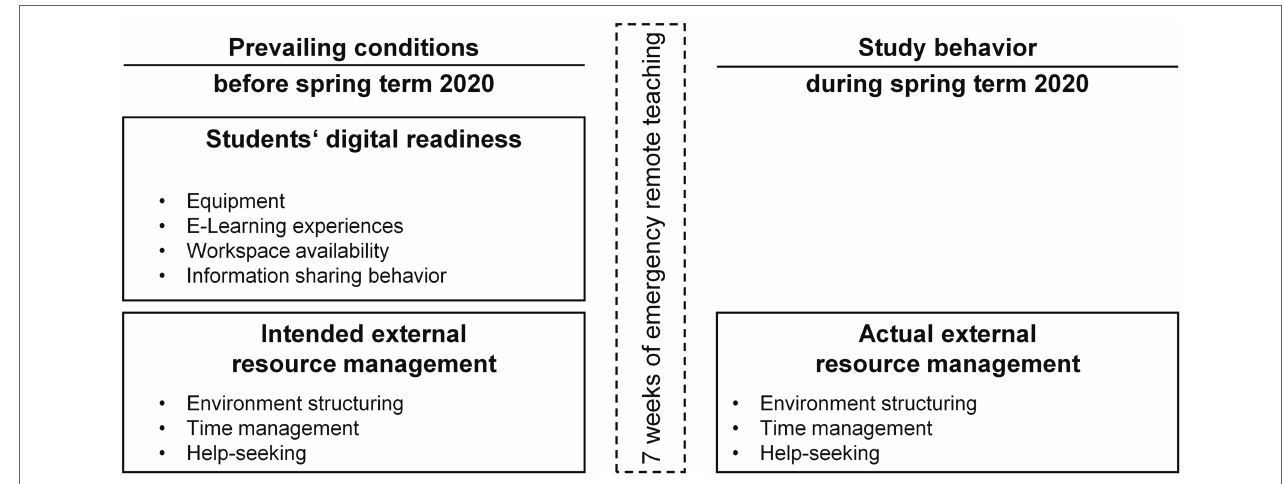
FIGURE 1 | Assessed constructs and variables at both measurement time